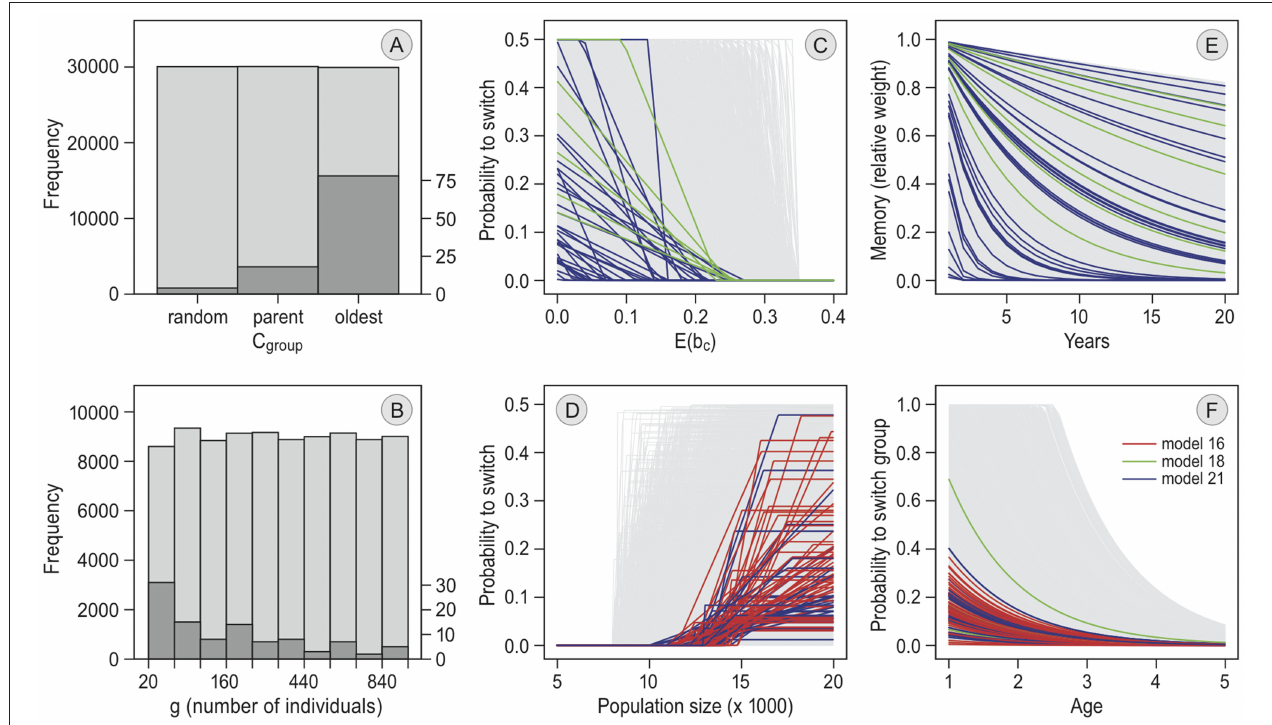
FIGURE 5 | Parameter values of selected simulation runs. The pre-defined parameter distributions from which random values were drawn for each simulation are given in light gray. The frequency distributions of parameter values among the 100 selected simulation runs in the main model selection (see Table 2 ) are given in dark gray. In the line graphs, each model is shown in a different color. For the bar plots, patterns did not differ between models. (A) gives the following criterion in each simulation of the models with “groups” (parameter c group ). (B) is the frequency distribution of the maximum group size in each simulation run (parameter g ). The lines in (C) define how the annual switching probability depends on the individual’s expected probability of reproducing at the current staging site, E(b c ). They are determined by parameters x a (threshold value below which the probability becomes non-zero) and x r (the slope of the line below x a ) in the models with memory but without exploration. In (D) , the lines are determined by parameters ge 0 , ge r and ge m in the models with “reconsider geese ”, which determine how the probability to switch preference after arrival at the staging site, depending on the number of geese there. (E) shows how, resulting from differences in m , the weight of each memory declines over the years. The lines in (F) depend on parameters w 0 and a r , and define how the probability of switching between groups decreases with age in each simulation (only models 16 and